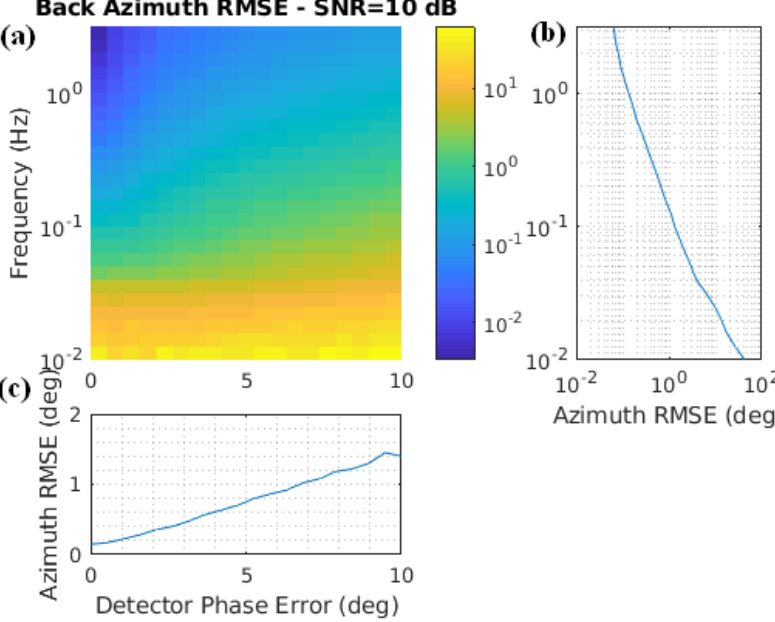
Figure 21. The same as Figure 19 but with an SNR of 10 dB. ( a ) RMSE for a case with no noise, and a consistency threshold of 0.1 s, as a function of frequency and sensor phase error, ( b ) median RMSE over all sensor phase errors, ( c ) median RMSE over all frequencies.